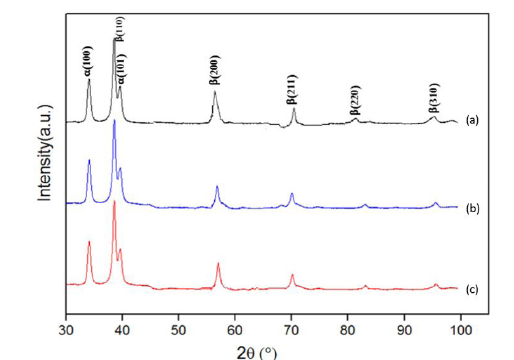
Figure 1. X-ray diffraction patterns of the equimolar TiNbZr alloys with different weight ratios of NH Equimolar TiNbZr; b) 20 wt% NH NH Table 2. Density, porosity, mechanical properties and wear rate of specimens of equimolar TiNbZr alloy and porous equimolar TiNbZr with different porosities. Specimen